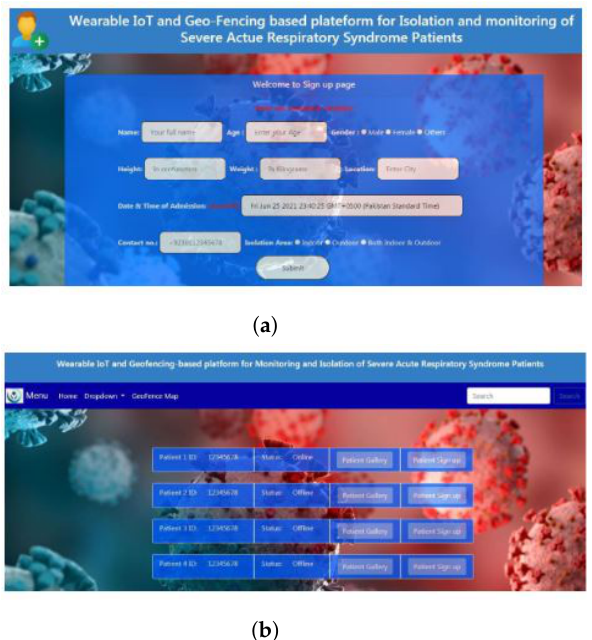
Figure 13. Flask server for local monitoring for patient condition. ( a ) sign up page for patients autho- rized for concern authorities only; ( b ) index page with patient sign up and patient data integrated